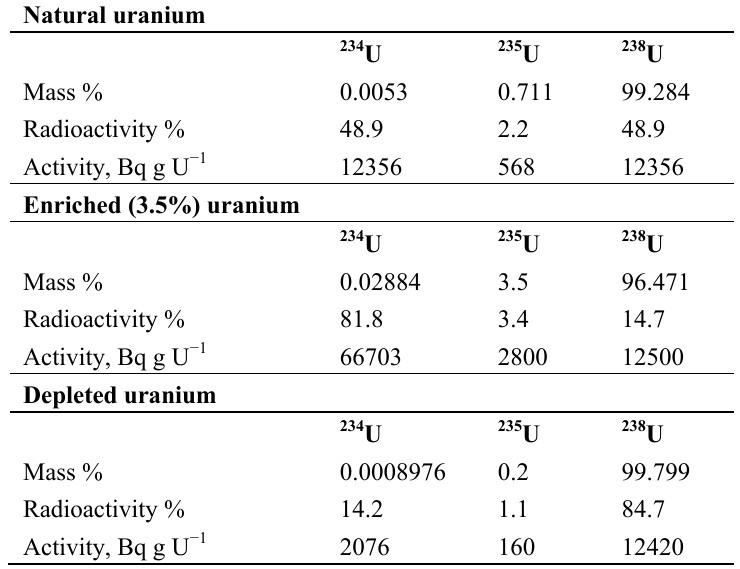
Table 3. Isotopic distributions in natural uranium, enriched uranium and depleted uranium [9].